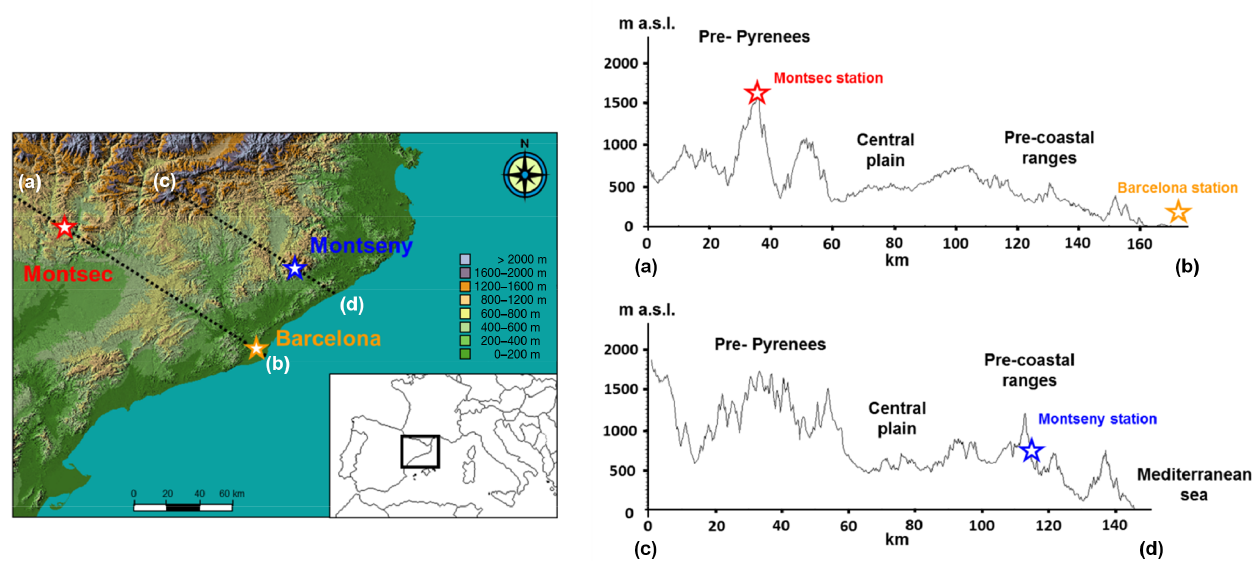
Figure 1. Map location and topographic profiles of Barcelona (BCN; urban background), Montseny (MSY; regional background) and Montsec (MSA; remote mountain-top background) measurement